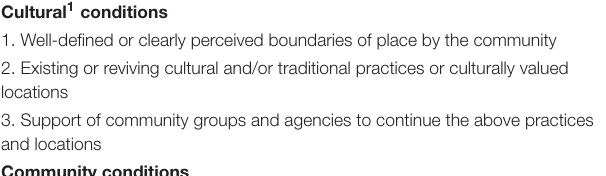
TABLE 1 | Considerations for Identifying Place(s) and Community(ies) that can help ensure research process and outcomes have greatest benefit to all involved. Cultural 1